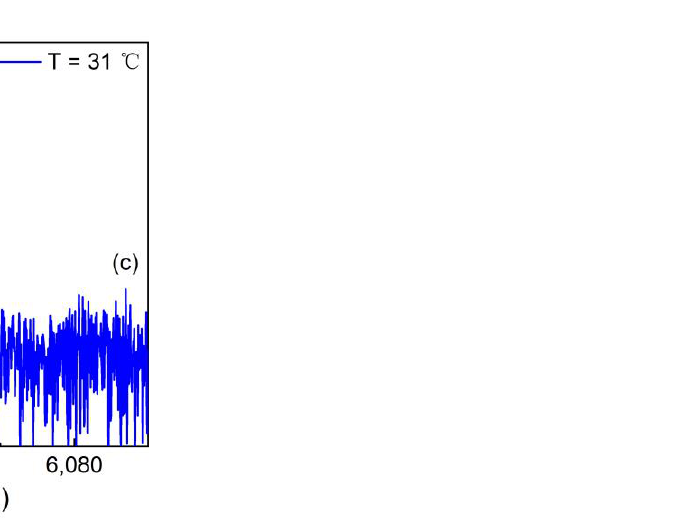
Figure 3. The output performance of the 6057.10 cm −1 CW-DFB laser. ( a ) The trend of laser output wavelength. ( b ) The laser output power. ( c ) The emission spectrum of the 6057.10 cm −1 CW-DFB laser.